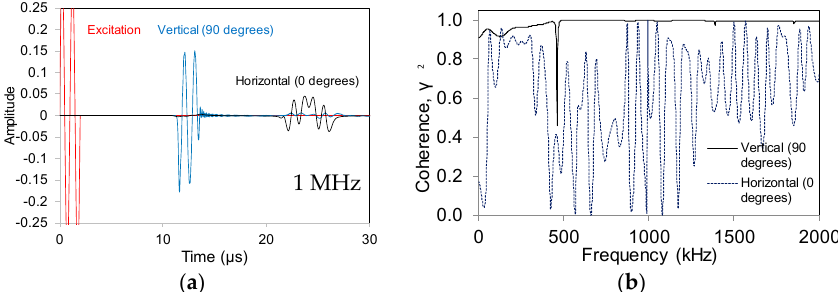
Figure 10. ( a ) Waveforms received by the 5 mm size sensor emitted from source set on the surface (in black) and vertically beneath the sensor (in blue) with excitation frequency equal to 1 MHz. Original waveform is added in red color and in reduced scale to fit the graph; ( b ) Respective coherence functions between received waves and original.